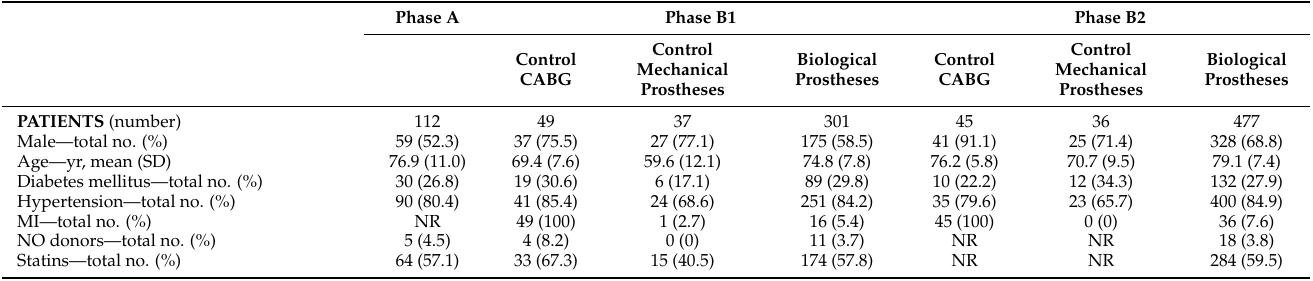
Table 1. Patients’ characteristics at the time of entering the study and surgical